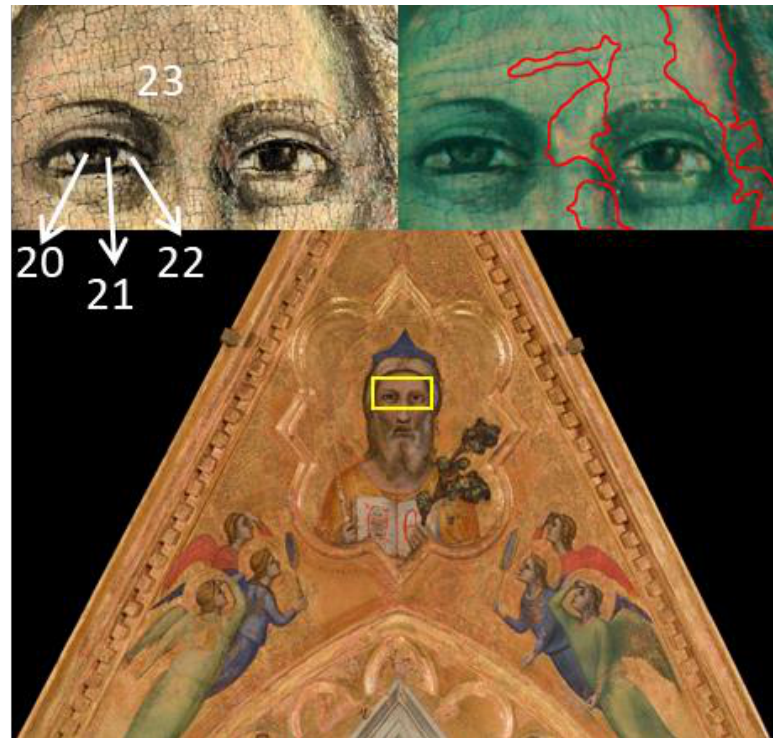
Figure 1. The gable of San Diego; the yellow rectangle surrounds the area of the X-ray fluorescence (XRF)-mapping used as a database. The Left Zoom of the scanned area highlights the locations of the isolated spectra collected within the mapped zone; the numbers refer to Table 2. The Right Zoom shows the infrared false-color image of the scan: the greenish tone reveals the original layers while the red profiles outline the principal zones affected by restorations.